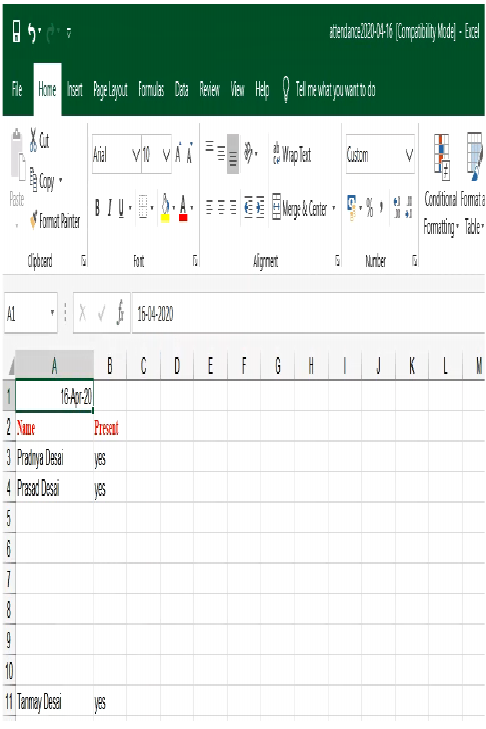
Figure 7. Attendance being marked using excel